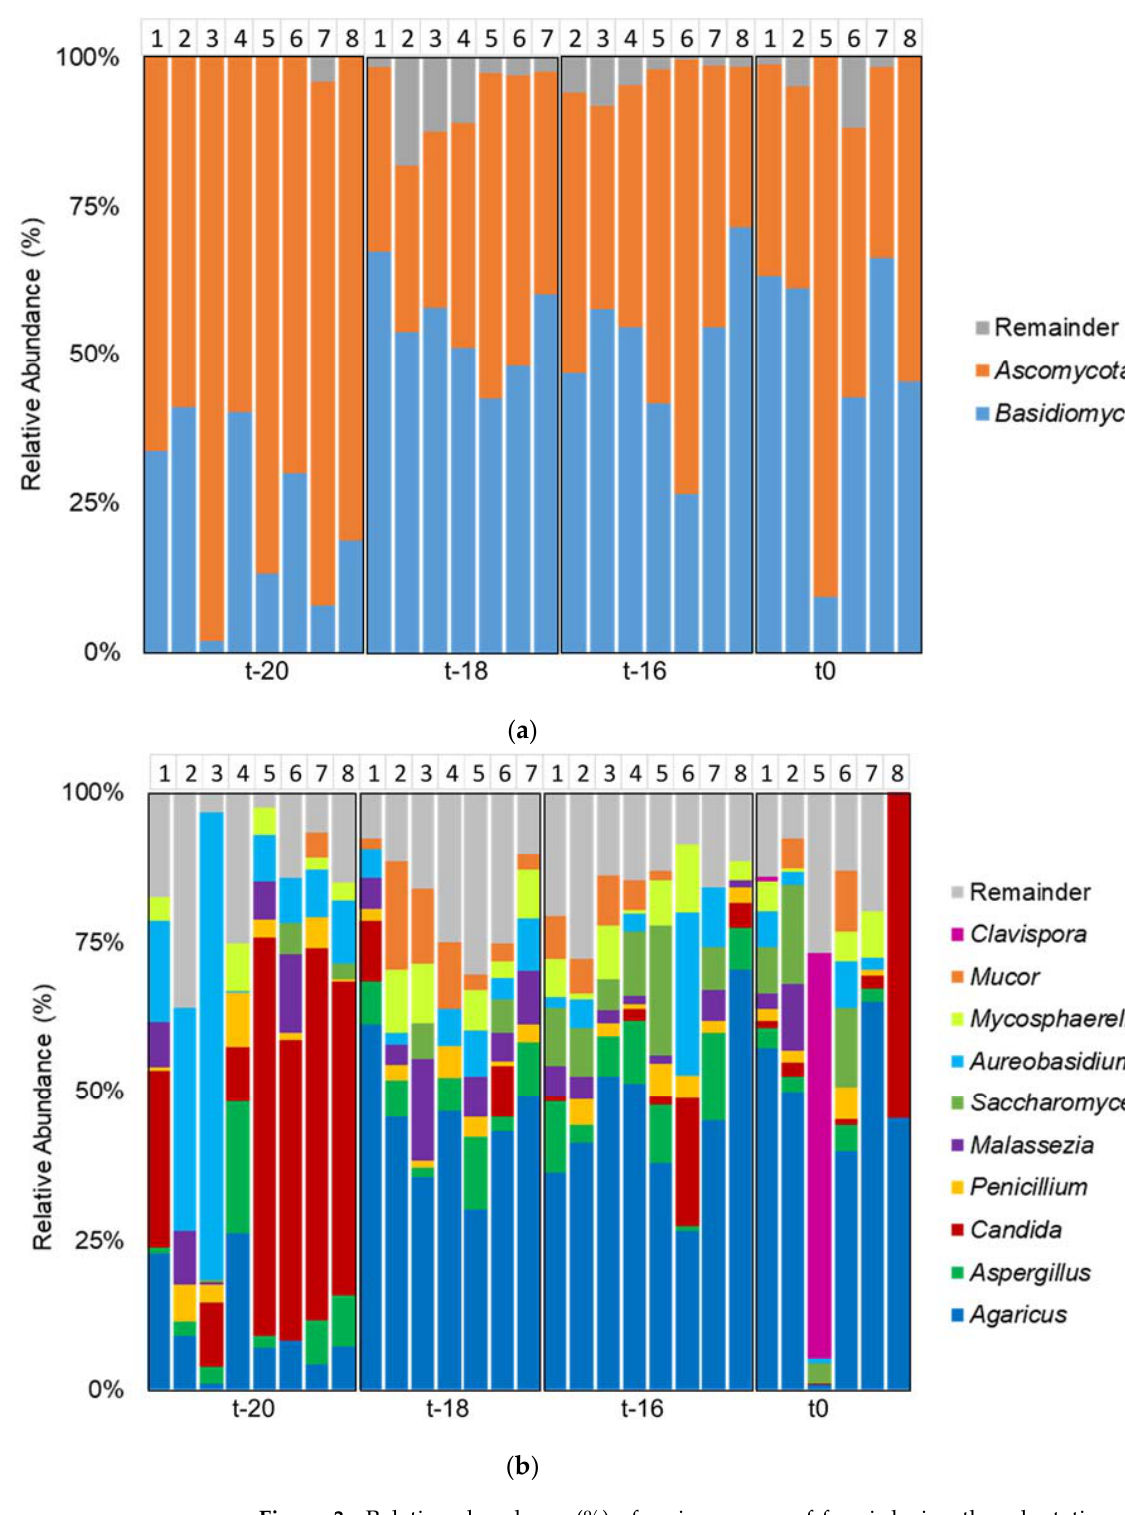
Figure 3. Relative abundance (%) of major groups of fungi during the adaptation period after inoculation in TIM ‐ 2; ( a ) phyla; ( b ) genera; N = 8 for t - 20, t - 18 and t - 16, n = 6 for t0, due to two samples not passing the quality filtering.